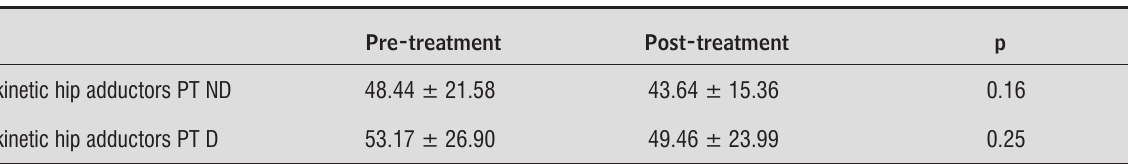
Table 2 - Isometric and isokinetic hip abductors and adductors peak torque